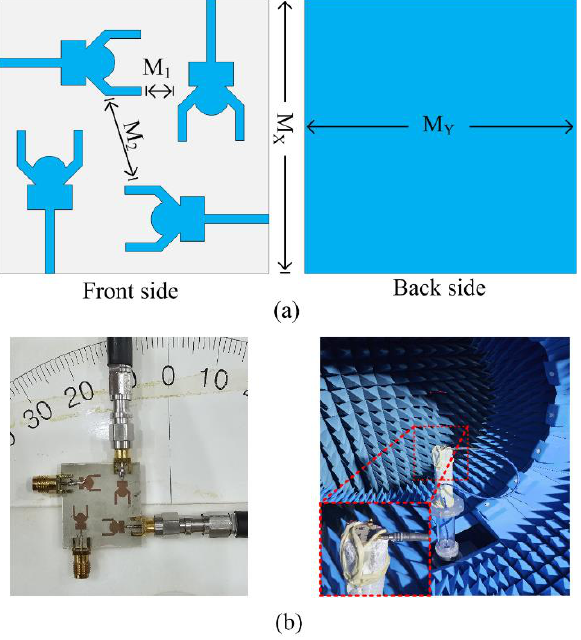
Figure 10. ( a ) Configuration of proposed MIMO antenna; ( b ) measurement setup for S-parameters and far-field